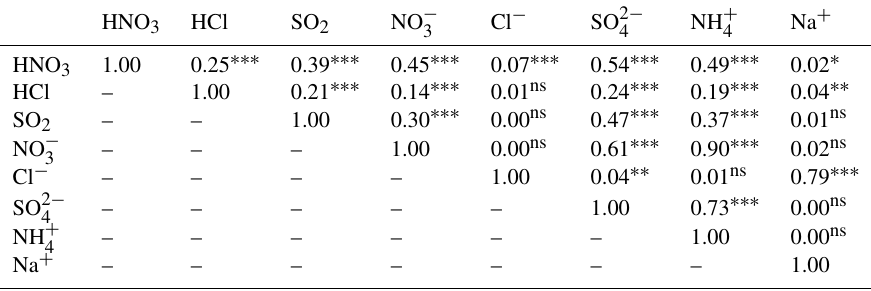
Table 2. Correlation coefficients ( R 2 ) for different species across the 30 measurement sites.